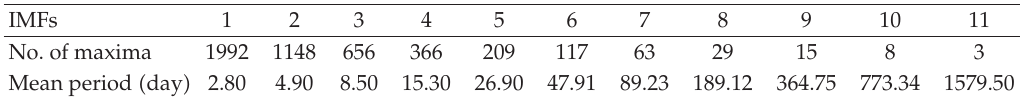
Table 1: Period statistics of daily evaporation data.